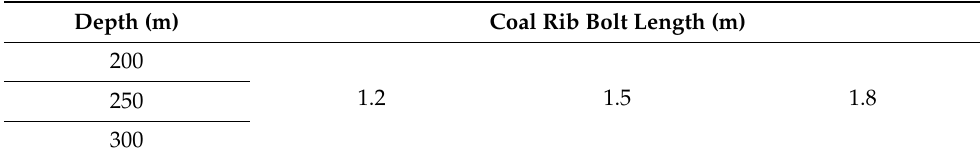
Table 4. Rock bolt length and rib depth for model